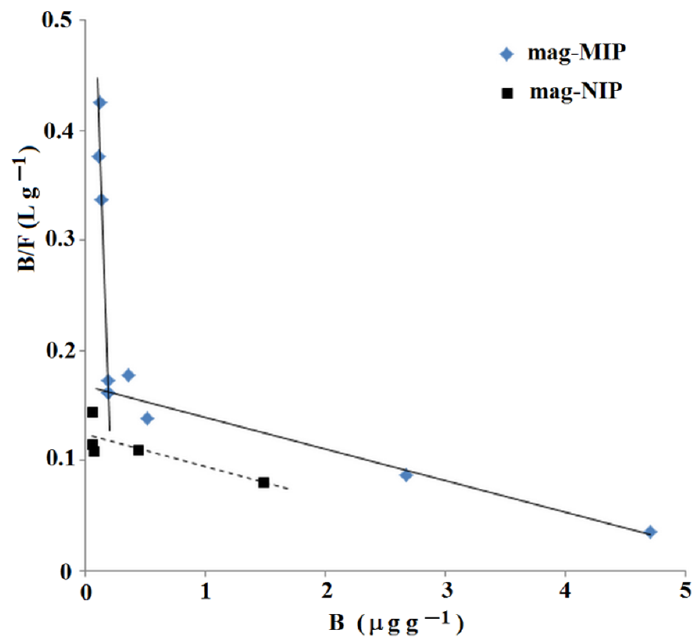
Figure 2. Scatchard plot for ANT-OH on mag-MIP and mag-NIP. Next, the adsorption kinetics of ANT and ANT-OH on mag-MIP and mag-NIP were evaluated because the time of adsorption is an important parameter during the optimization of d-SPE. Obtained kinetics data on mag-MIP and mag-NIP for ANT and ANT-OH fitted well to Ho-McKay and Weber-Morris models (Figure 3).